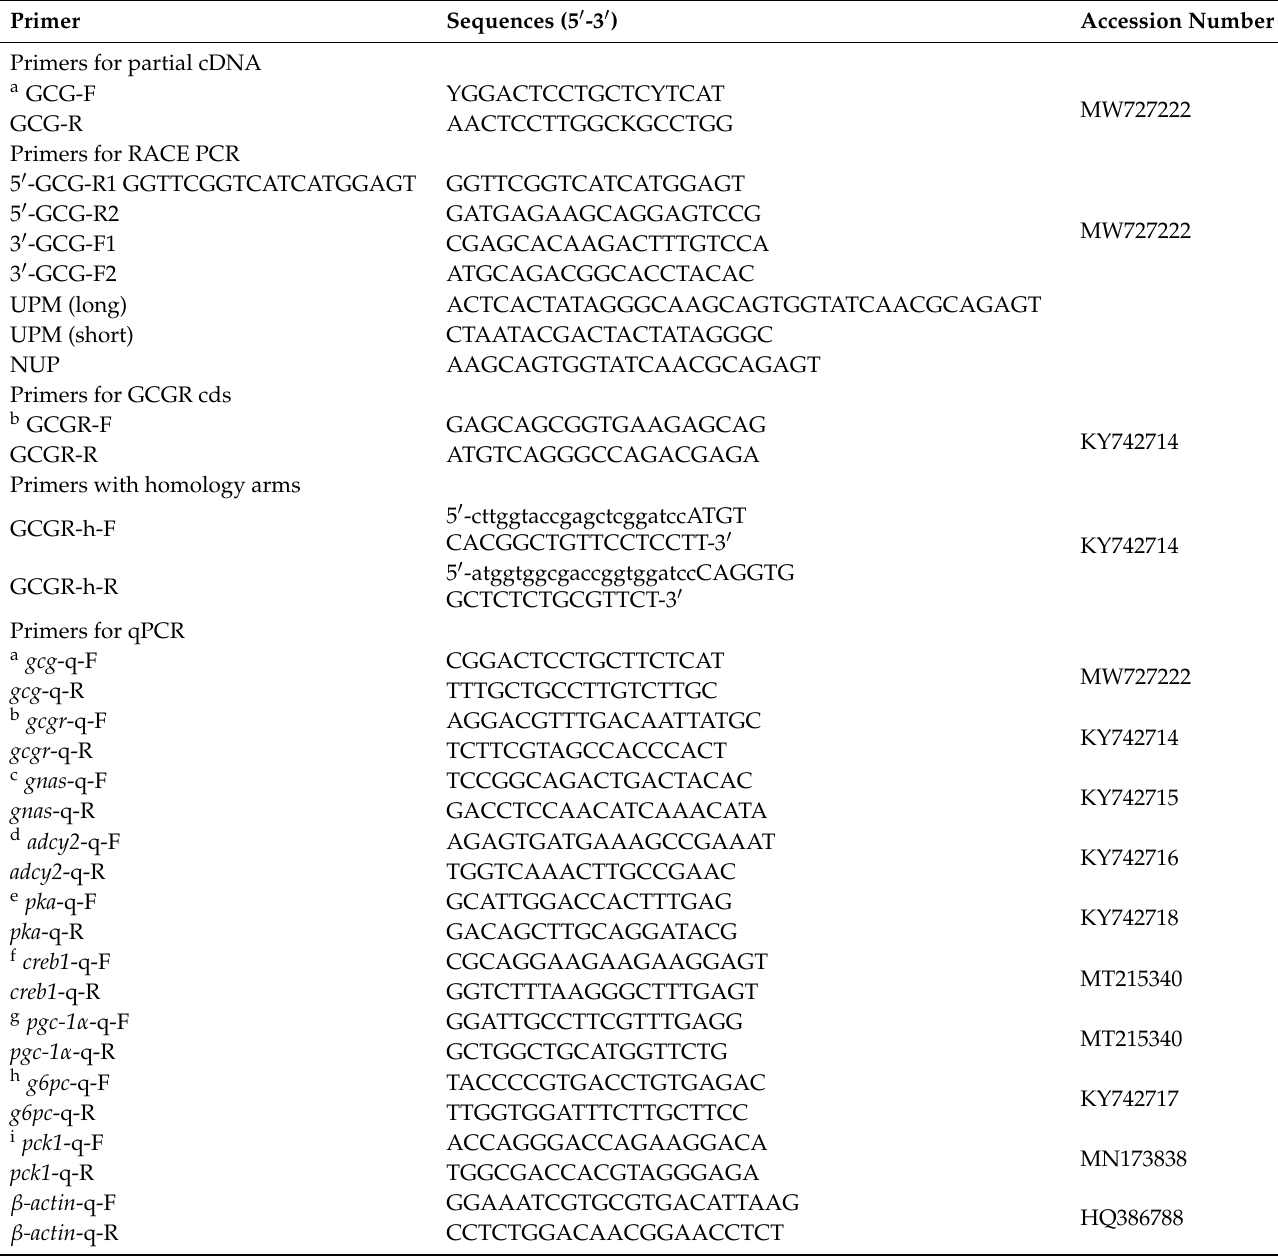
Table 1. Sequences of the PCR primers used for cloning, plasmid construction, and qPCR